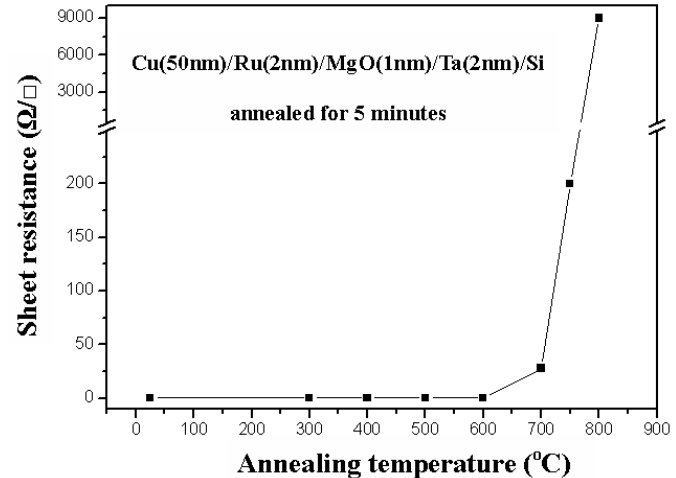
Figure 11. Relation between sheet resistance and annealing temperature for Cu (50 nm)/Ru